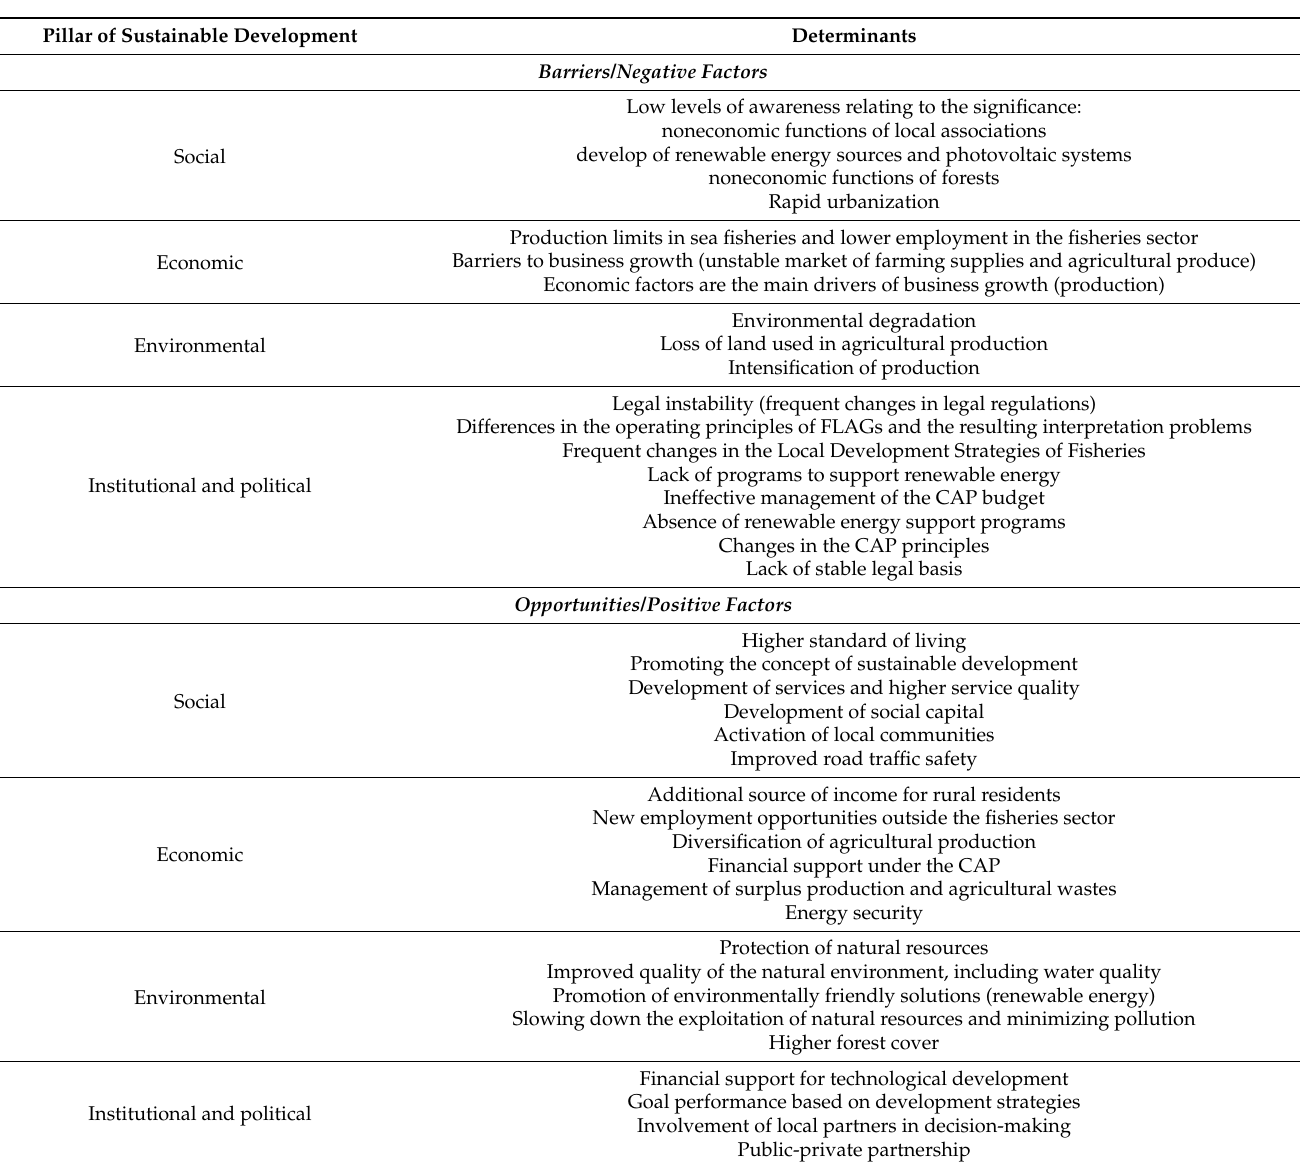
Table 1. The opportunities and barriers to the sustainable development of rural